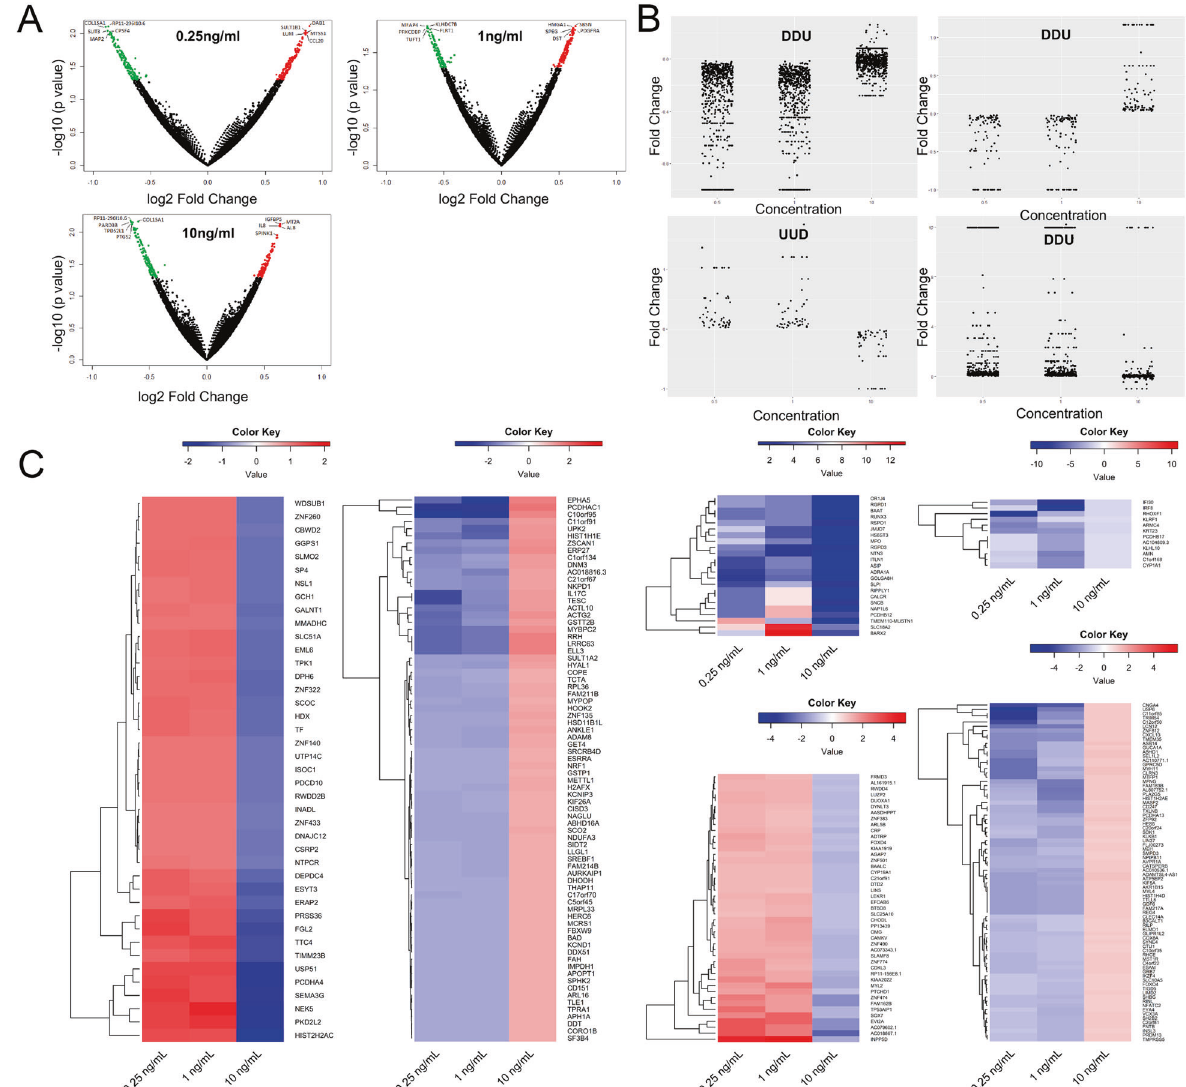
Fig. 7 Leptin-modulated molecular events, an enrichment analysis. Enrichment analysis showing A Volcano plots showing signi fi cantly altered candidates upon increasing doses of leptin (0.25, 1, and 10 ng/ml) with respect to control. Green dots are those genes downregulated in the case sample and red dots are those upregulated in the case sample, with the top fi ve genes in each direction being labeled. B The different cohorts represent the experimental observations UUD, UUN, DDU, and DDN, where U represents upregulated, D represents downregulated, and N represents no change. Each dot represents an individual gene within each designated pattern, with concentration plotted against fold change. C Heatmaps showing fold change with respect to the control for all patterns in genes across all concentrations. Heatmaps for UUN and DDN are split into two subplots showing the most differential fold change in the two major subgroups of fold change since fold change is not consistently the same across all